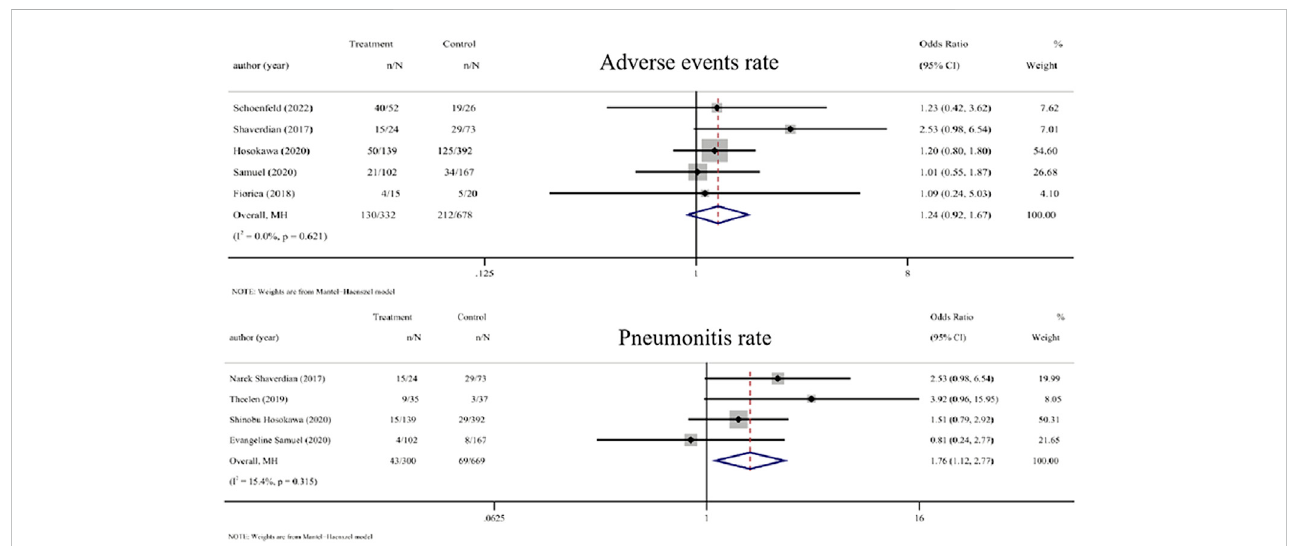
FIGURE 4 Forest plot of the adverse events rate and pneumonitis rate associated with RT combined with ICIs versus ICIs alone. In terms of adverse events rate and pneumonia rate, the ORs of RT combined with ICIs treatment were 1.24 (0.92, 1.67) and 1.76 (1.12, 2.77), respectively. Abbreviations: RT, radiotherapy; ICIs, immune checkpoint inhibitors; OR, odds